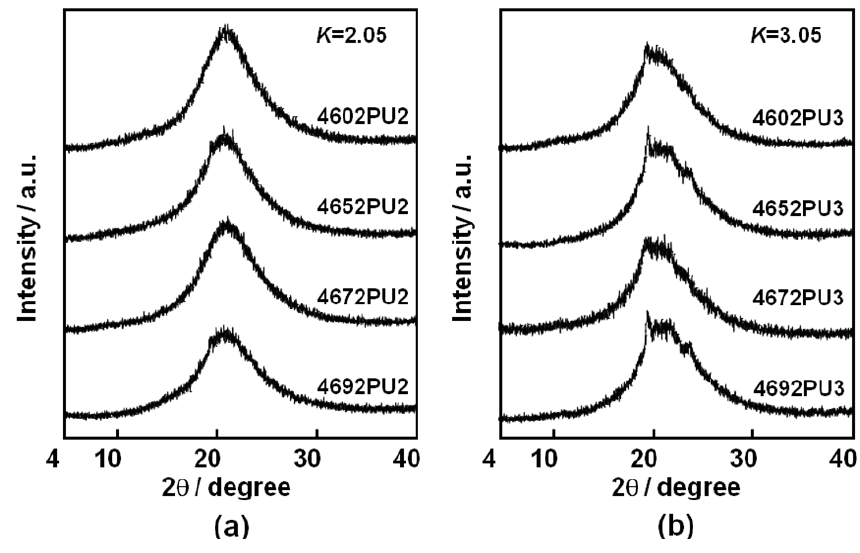
Figure 6. WAXD patterns for PC-glycol-based PUEs. ( a ) K = 2.05 and ( b ) K =